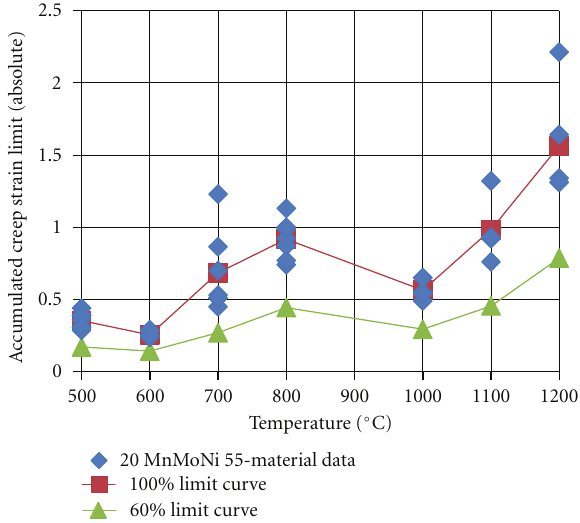
Figure 5: Steel 20 MnMoNi 55. Approach for definition of uniaxial creep